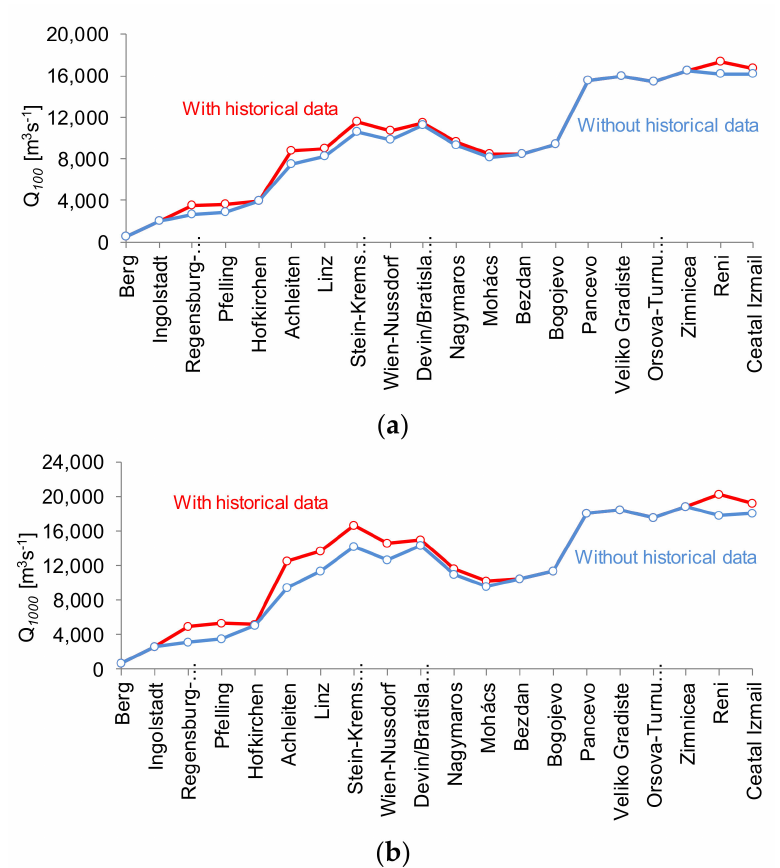
Figure 5. Differences in the estimated maximum discharges with return periods of ( a ) 100 years and ( b ) 1000 years along the Danube River, estimated according to LPIII distribution with historical data (11 red points) and without historical data (20 blue